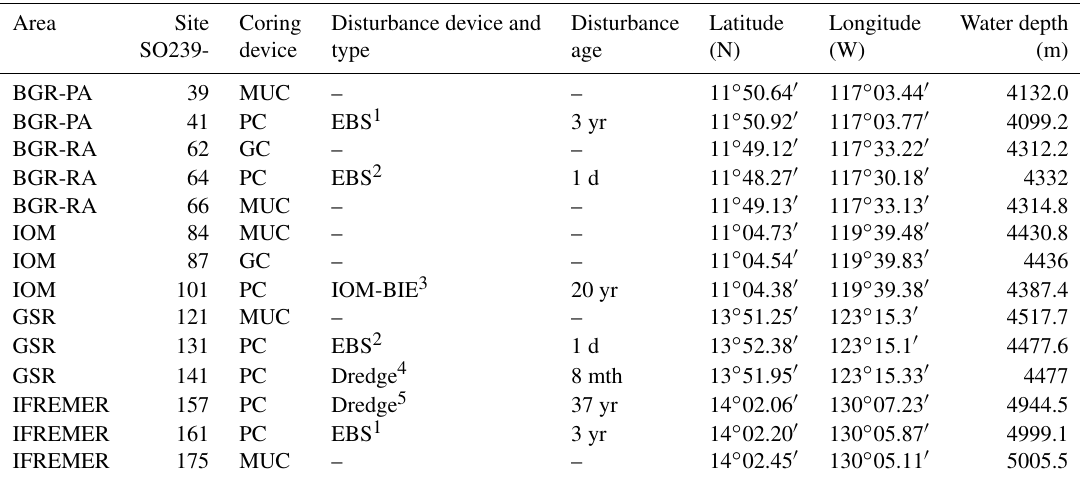
Table 1. MUC and PC cores investigated in this study, including information on geographic position, water depth, type and age of the disturbances (years: yr; months: mth; days: